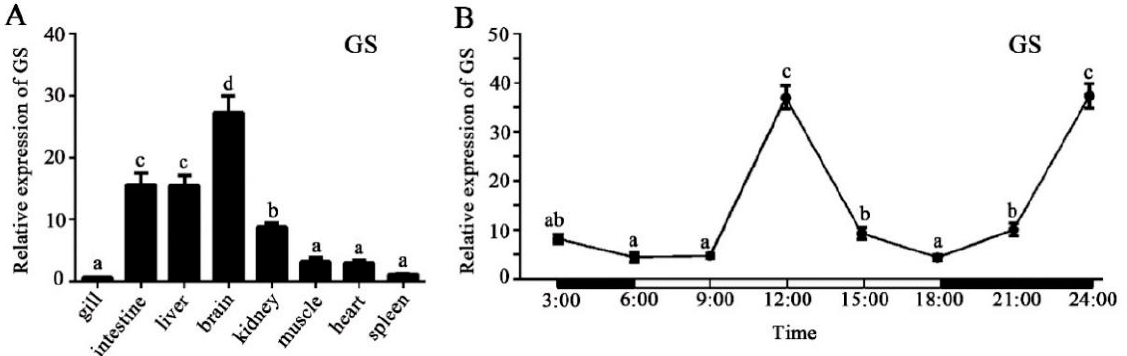
Figure 2. Analysis of tissue expression and rhythm expression of GS. ( A ) Tissue expression profile of GS; ( B ) the rhythm expression analysis of GS. β -actin was used as an internal reference. Tukey’s multiple range test was performed and different letters represent significant differences ( p < 0.05, n =